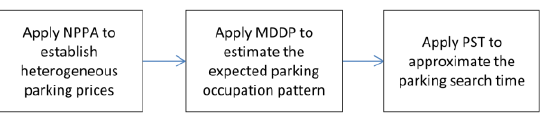
Figure 4. Major computational blocks of